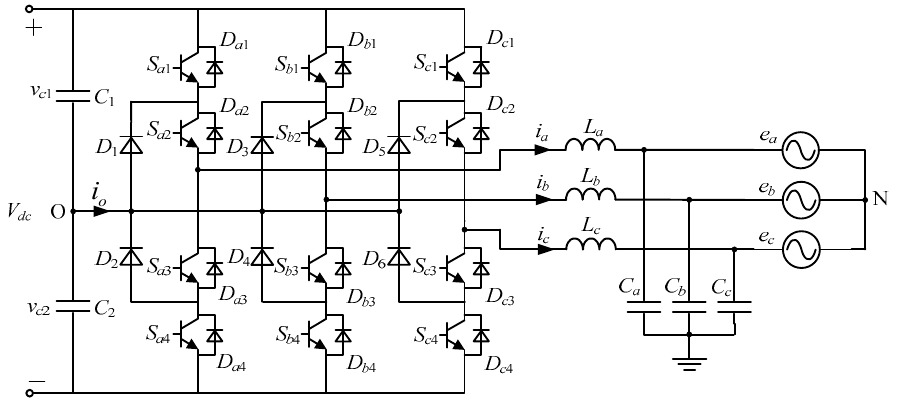
Figure 1. Main circuit of the NPC three-level grid-connected inverter.